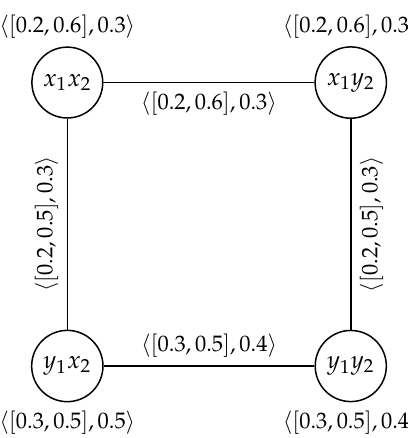
Figure 7. The Cartesian product G 1 and G 2